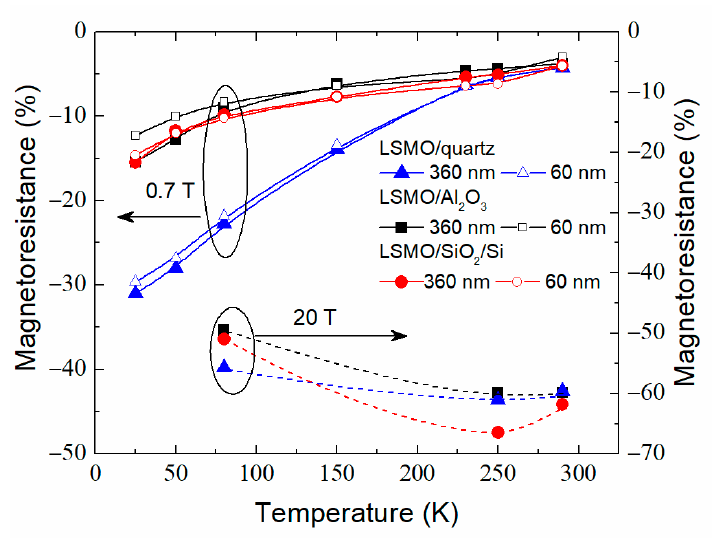
Figure 12. Magnetoresistance dependences on temperature at 0.7 T (left scale) and 20 T (right scale) for LSMO films grown on different substrates.